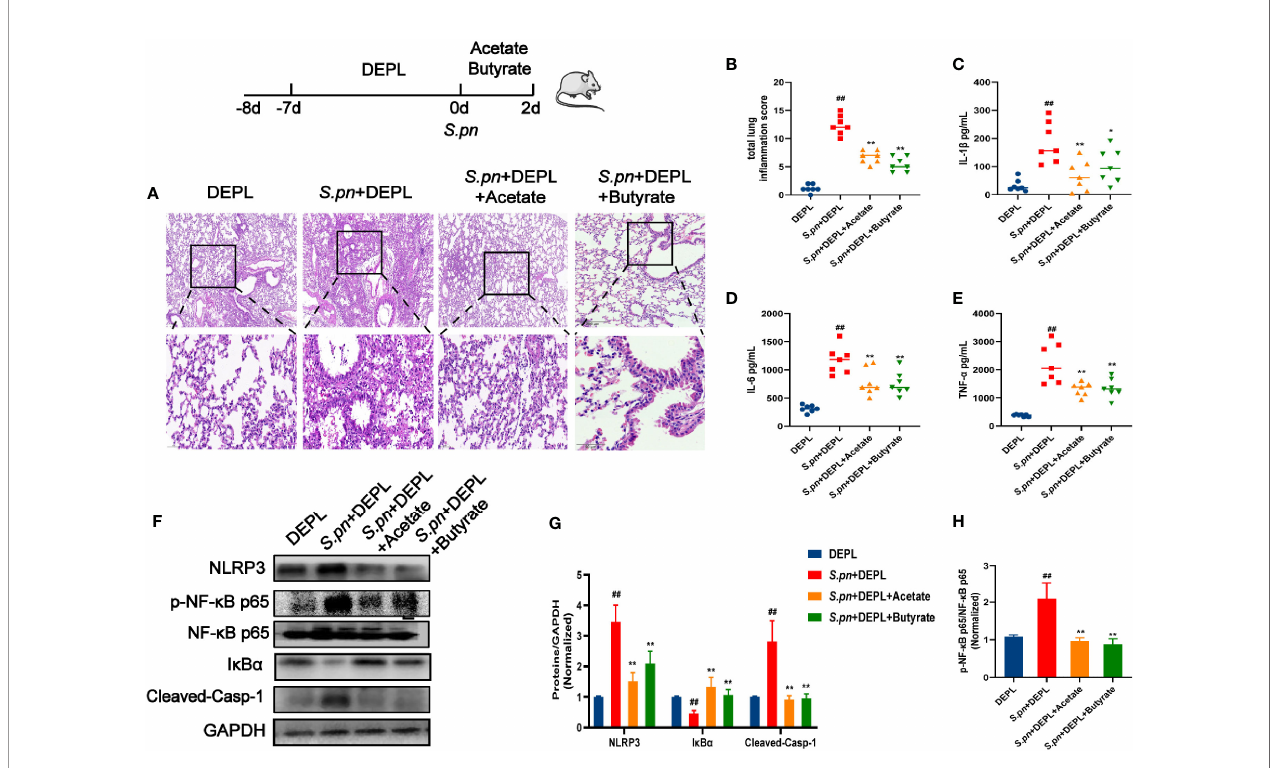
FIGURE 6 | SCFAs Administration Alleviated Lung in fl ammation in DEPL Mice after S.pn Infection. DEPL, S.pn +DEPL, S.pn +DEPL +acetate, and S.pn +DEPL + butyrate groups of mice were administered broad-spectrum antibiotic in drinking water then were inoculated with 2.5 × 10 8 CFU/mL S.pn 25 m L and monitored for 48 h. (A) Pathologic and histopathological changes in lung tissues as revealed by H&E staining (original magni fi cation 40×, scale bar: 20 m m). (B) Total lung in fl ammation score. (C – E) Levels of in fl ammatory cytokines IL-1 b , IL-6, and TNF- a in lung tissues. (F) Western blots revealing protein expression levels and (G, H) quanti fi ed protein levels determined from Western blot band areas and densities. Data are presented as the mean ± SD for each group, ## p < 0.01 versus DEPL; * p < 0.05, ** p < 0.01 versus S.pn